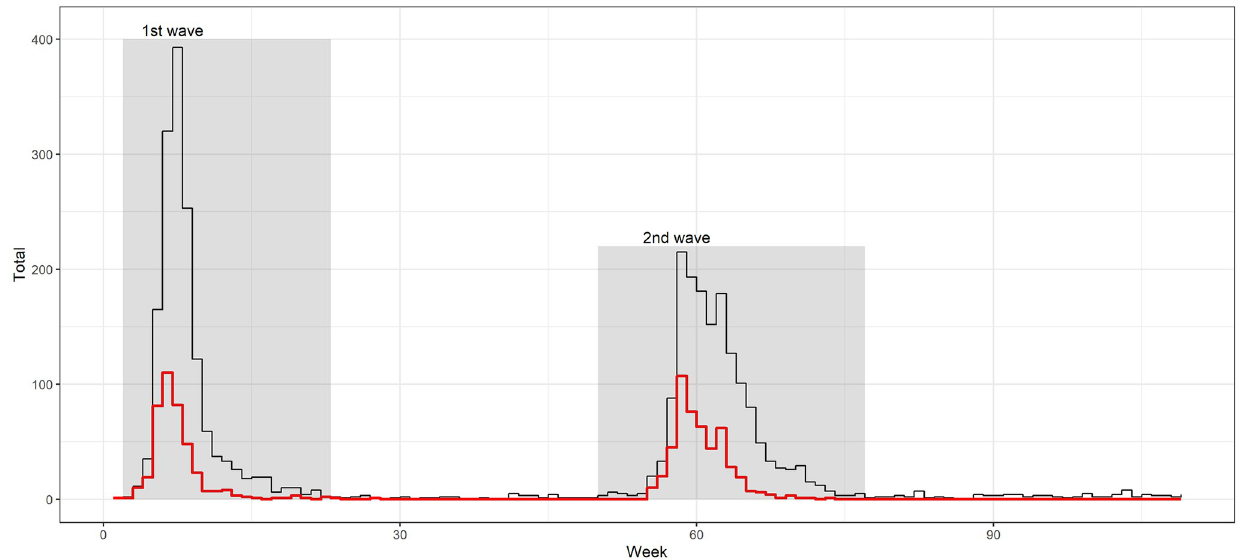
Fig 1. Historical series of reported (black line) and confirmed (red line) yellow fever cases, Minas Gerais, Brazil, 2016–2018. (Epidemiological weeks were transformed into a continuous count with 7-day intervals, totaling 109 weeks).